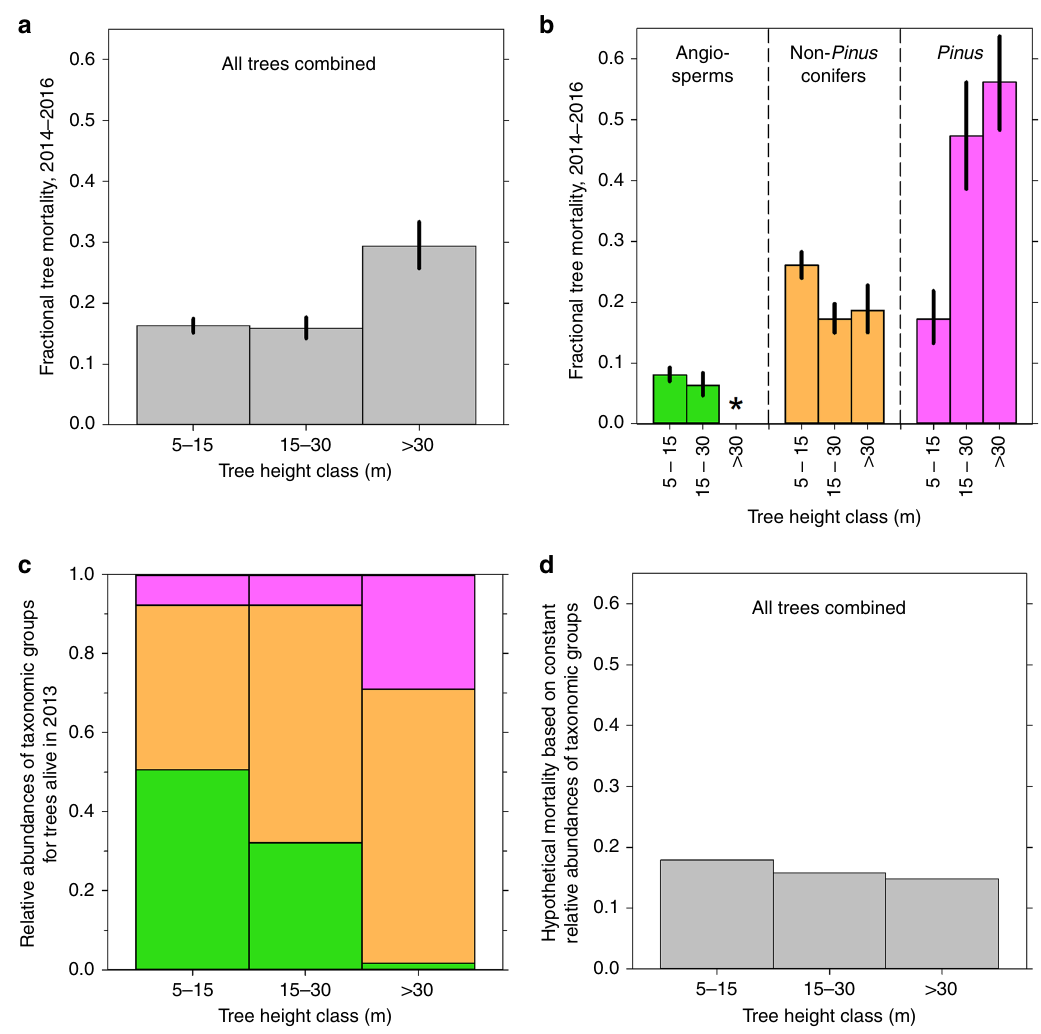
Fig. 1 Tree mortality and relative abundances of taxonomic groups by height class during the extreme drought. a 2014 – 2016 mortality by height class, all trees combined. Bar heights show mean mortality (with 95% credible intervals) derived from the posterior distributions of parameters estimated from 45,000 Markov Chain Monte Carlo iterations (three 15,000-iteration chains), as described in Methods. b 2014 – 2016 mortality by height class for each taxonomic group (bar heights and credible intervals are as in a ). None of the 9 angiosperms >30 m tall died, yielding 0 mortality; for reference, the asterisk indicates mortality for a larger sample (the 71 angiosperms >25 m tall). Numbers of sampled trees contributing to the other combinations of taxonomic group and height class are given in Supplementary Table 6 and Supplementary Fig. 3. c Relative abundances of the taxonomic groups within each height class, for trees alive in 2013 (green = angiosperms; orange = non- Pinus conifers; magenta = Pinus ). d Hypothetical 2014 – 2016 mortality for all trees combined, calculated using actual height- and taxa-speci fi c mortality values but assuming constant relative abundances of taxonomic groups across height classes (Supplementary Table 4). Because these results are hypothetical, no credible intervals are